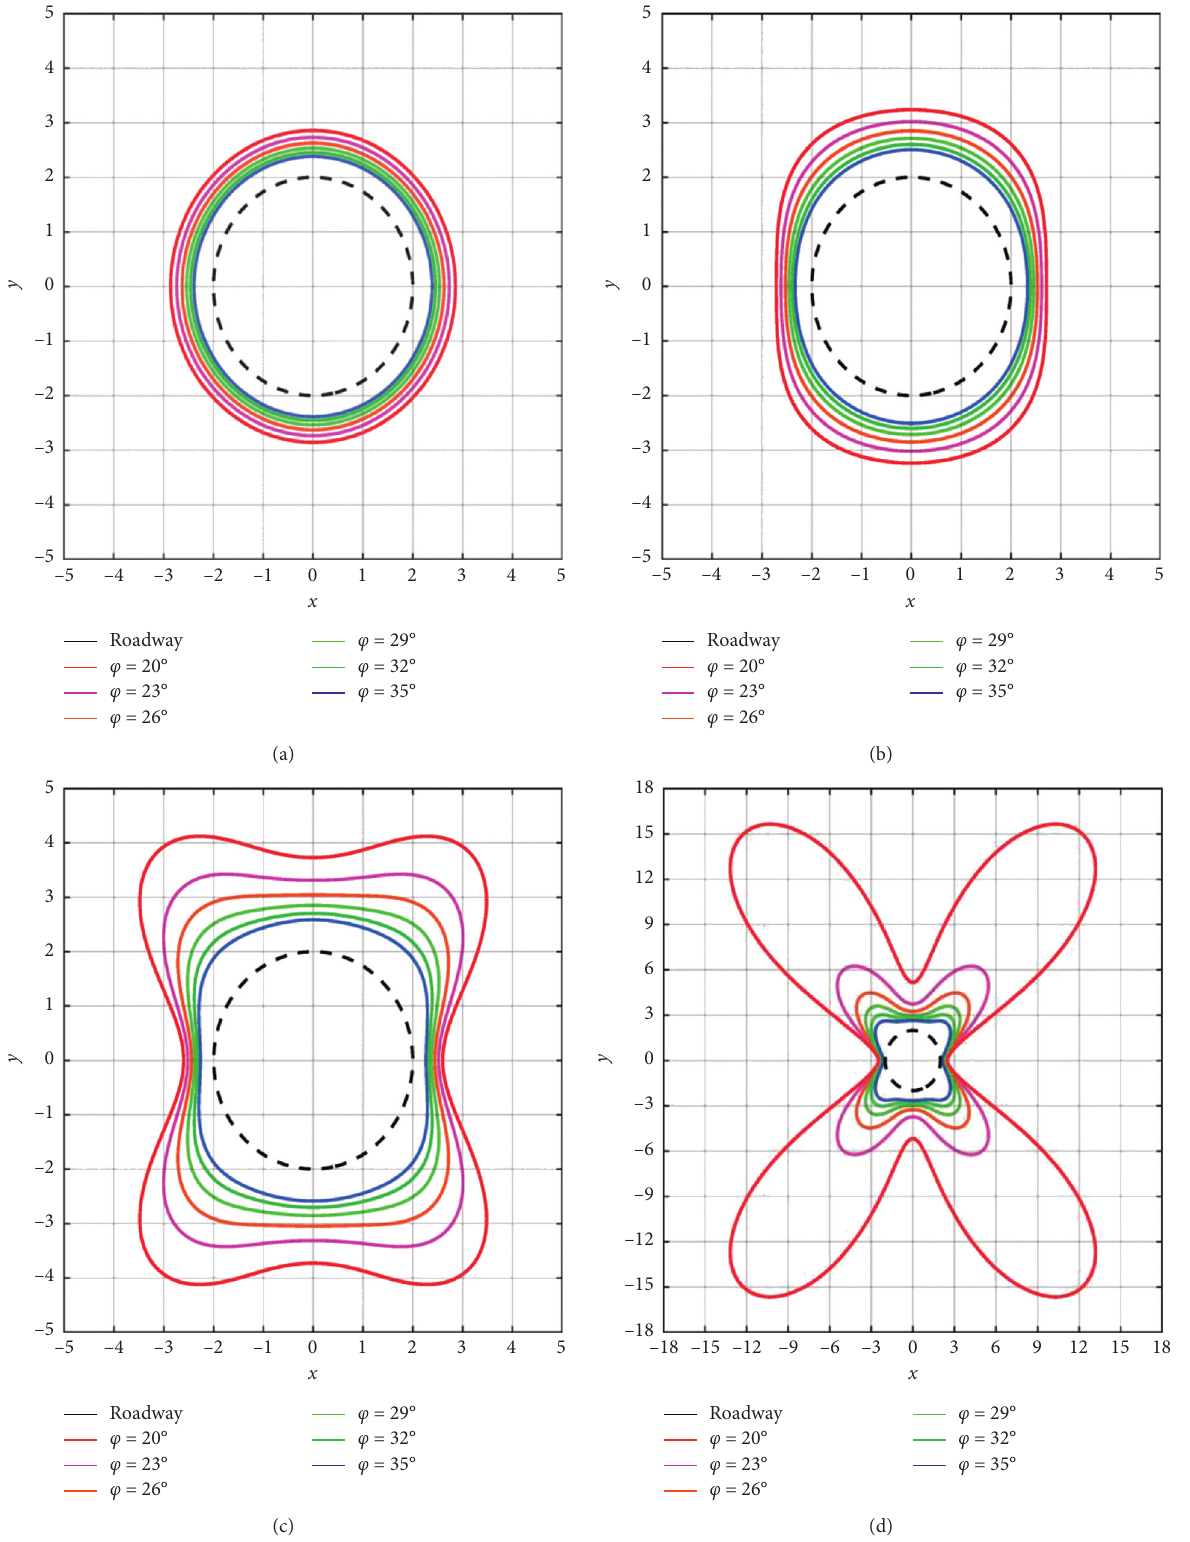
Figure 10: Plastic zone distribution characteristics for various internal friction angles. (a) λ � 1.00. (b) λ � 1.48. (c) λ � 1.96. (d) λ �